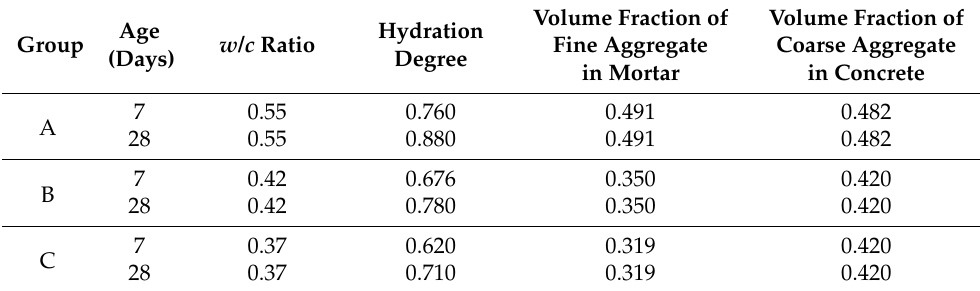
Table 4. The parameters of experimental materials.